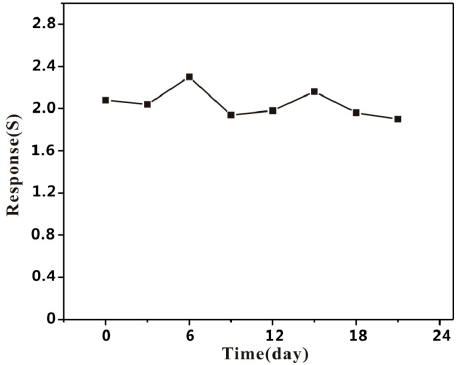
Figure 12. Stability of the Au-modified HPSCZNs sensor to 100 ppb of TMA.